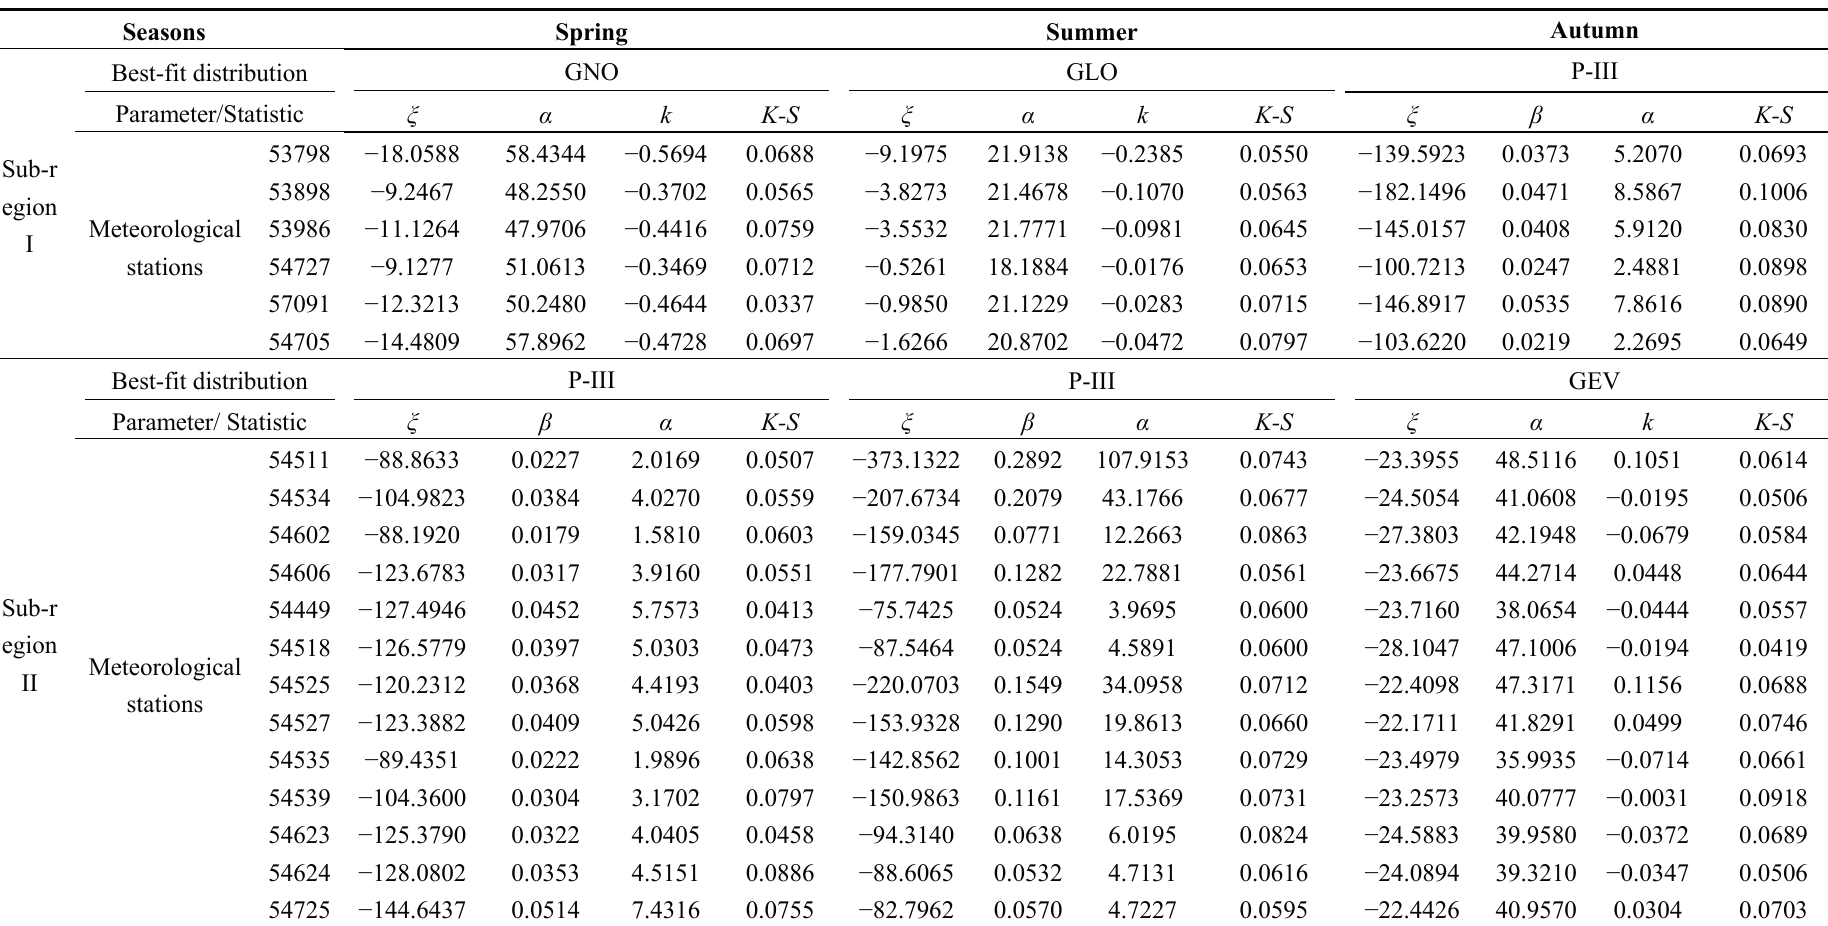
Table 7. Parameter estimates and K-S test values of the best-fit distribution for precipitation anomaly percentage in spring, summer and autumn in